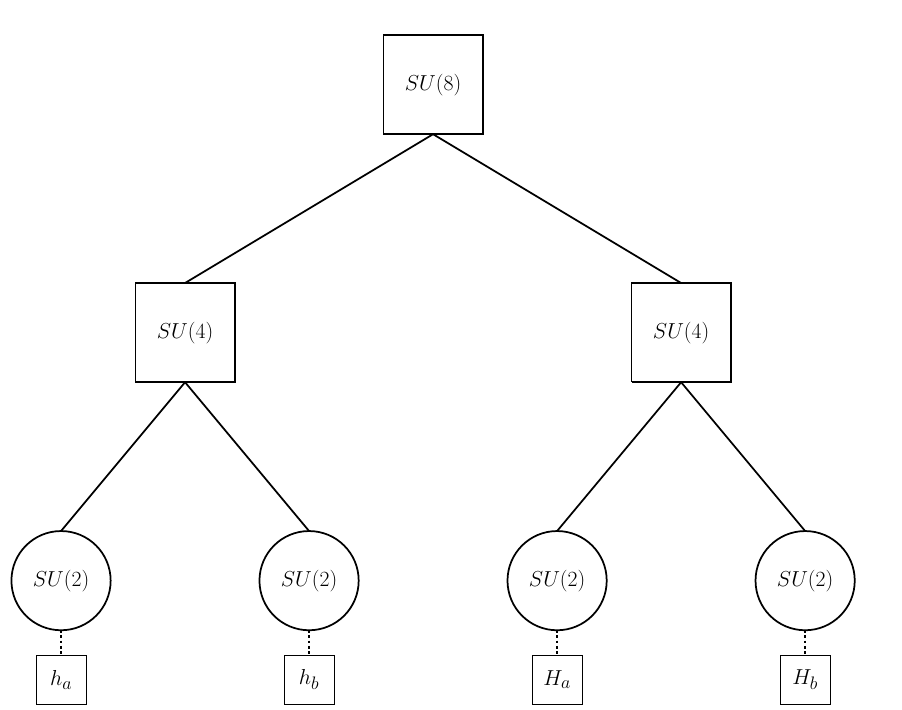
Figure 1 . The symmetry structure of the Twin Turtle model pursued in this work, in which a softly-broken Twin Higgs model is UV completed by yet another Twin Higgs model with certain hard-breaking quartics. Only the SU(2) groups are gauged; the SU(4) and SU(8) are approximate global